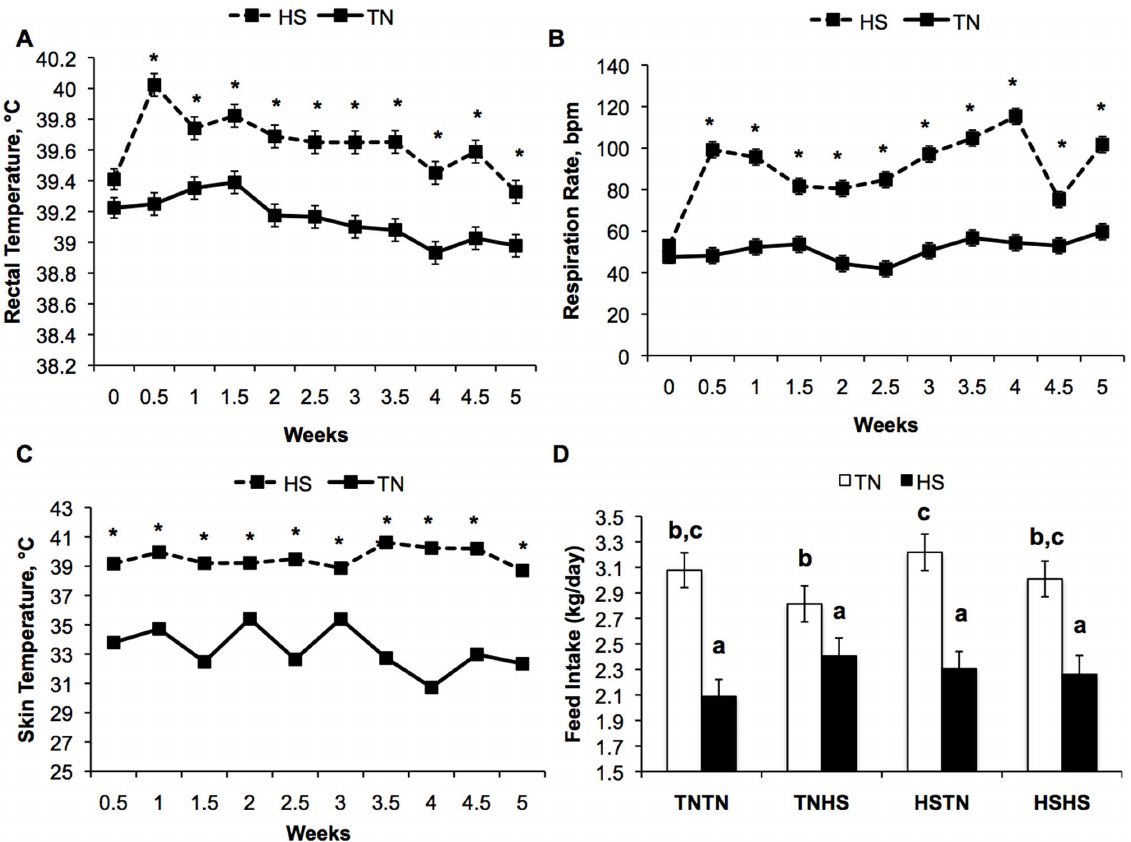
Figure 3. Chronic postnatal heat stress (HS) alters temperature indices and feed intake over the five-week treatment period. A) Rectal temperature is elevated by postnatal chronic HS ( P , 0.001) and postnatal treatment interacts with time ( P , 0.05). B) Respiration rate, breaths per minute (bpm), is elevated in HS compared to thermal neutral [30] postnatal treatment ( P , 0.001), and a postnatal treatment by time interaction was also observed ( P , 0.001). C) Skin temperature was elevated as a result of postnatal HS ( P , 0.001) in addition to a postnatal treatment by time interaction ( P , 0.001). D) Feed intake is reduced in HS compared to TN pigs ( P , 0.001), and a gestational by postnatal interaction was observed where pigs from all gestation treatments had similar feed intake during HS conditions, but under TN conditions, pigs from HSTN treated dams had greater feed intake than those from TNHS dams, but not different than those from gilts subjected to HSHS or TNTN gestational treatments ( P= 0.04). Data show the mean 6 SEM of n=6 pigs per postnatal treatment per gestational treatment. * indicates P , 0.05 for postnatal treatment by time comparisons. Different letters indicate P , 0.05 for gestational by postnatal treatment comparisons.